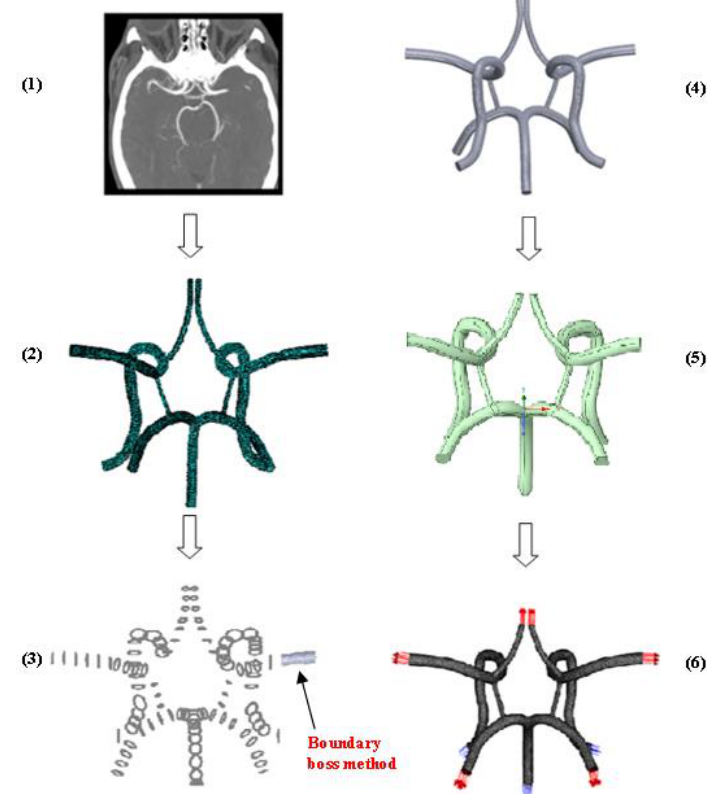
Figure 14. CoW computational model development methodology: (1) CTA scan, (2) point cloud image deployment, (3) cross sectional sketch uniting via boundary boss bass method, (4) full fluid core model after uniting the sketches, (5) Ansys SpaceClaim face healing, and (6) the final mesh and boundary condition assignment in Ansys Meshing.